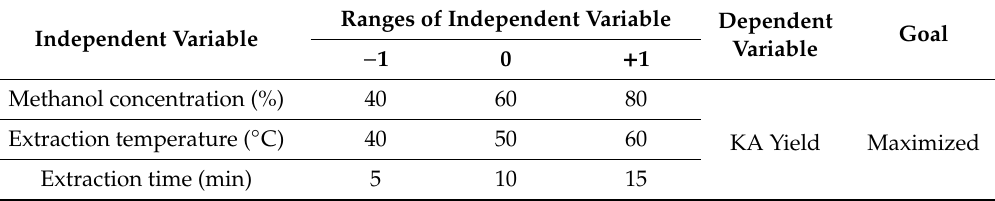
Table 2. Extraction variables selected for Ocimum basilicum optimization. KA: